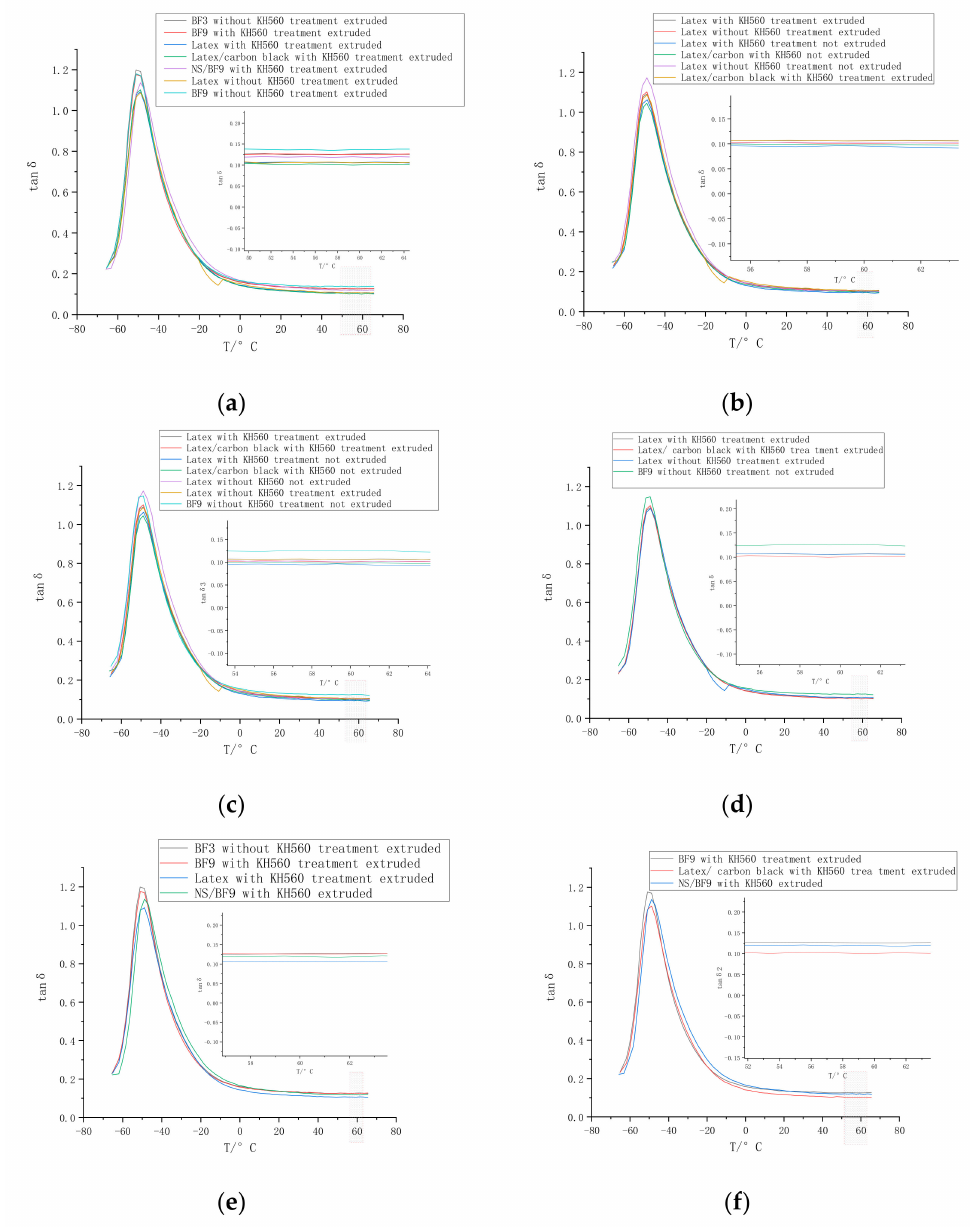
Figure 14. Results of DMA tests. ( a – f ): tan δ –T Curves of the